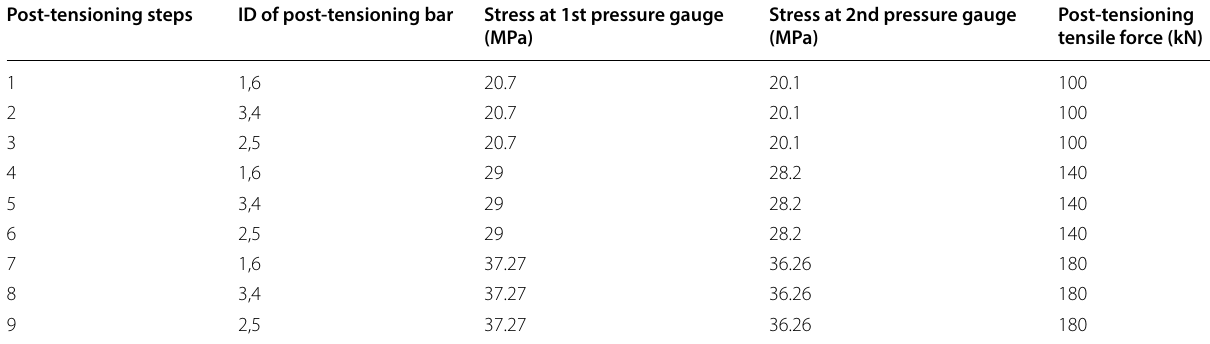
Table 2 Post-tensioning process of steel bars.